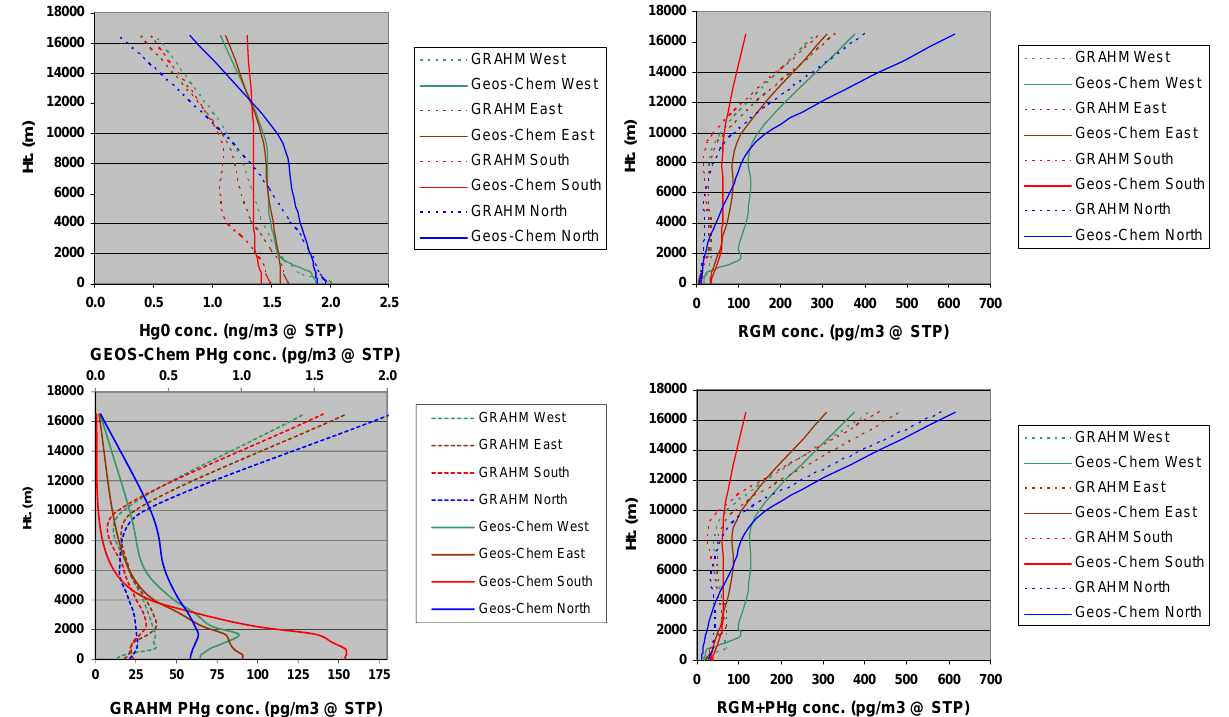
Fig. 1. Comparison of average vertical profiles of boundary conditions derived from the GEOS-Chem and GRAHM global models. (Note that different scales are used for GEOS-Chem and GRAHM PHg concentrations.)